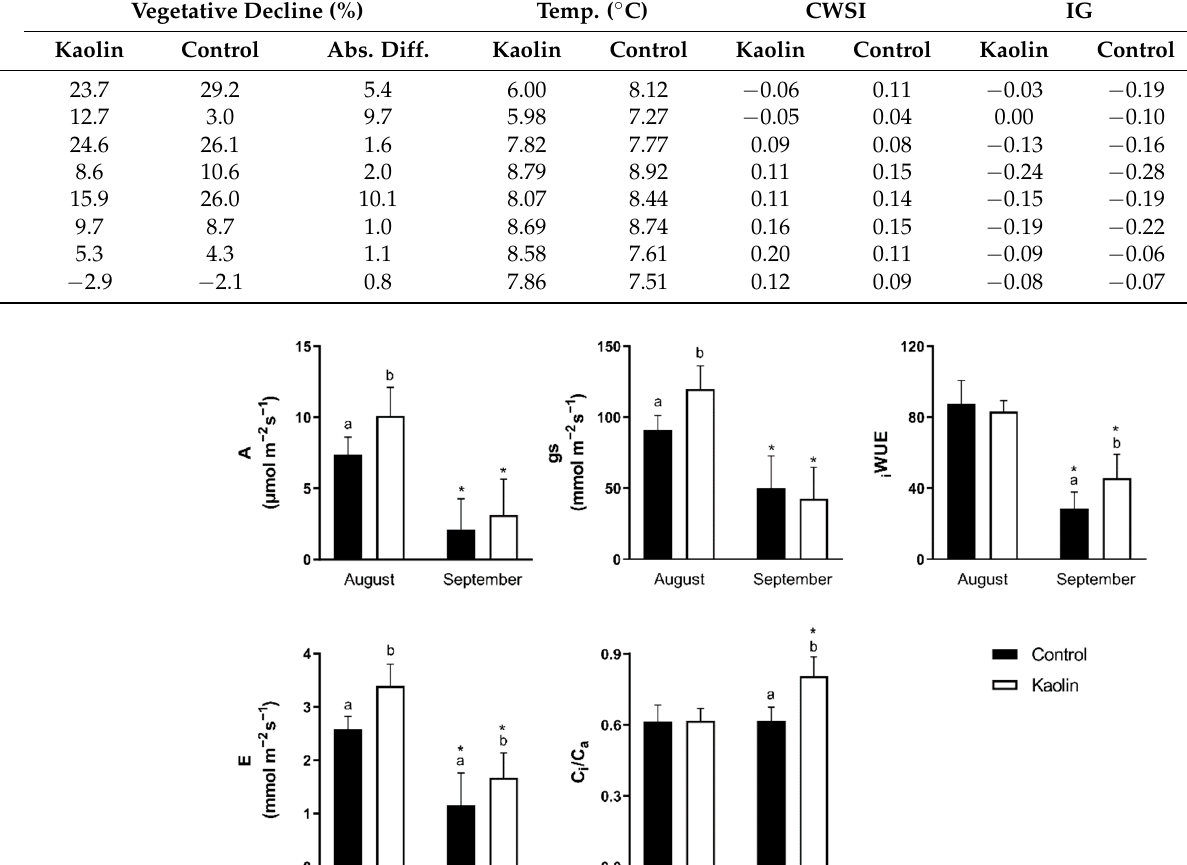
Figure 6. Leaf gas exchange parameters of Touriga Nacional control and kaolin ‐ treated grapevines at midday (14:00 GTM+1). Stomatal conductance (g s , mmol m − 2 s − 1 ), net CO 2 assimilation rate (A, µ mol m − 2 s − 1 ), intrinsic water use efficiency (A/g s , μ mol mol − 1 ), intercellular CO 2 concentration (C i ), ratio of intercellular to atmospheric CO 2 concentration (C i /C a ), and transpiration rate (E, mmol m − 2 s − 1 ). Data are mean ± SD of six replicates. Different lower ‐ case letters represent significant differences between treatments (control vs. kaolin ‐ treated) within each month. * p < 0.05 represent significant differences between sampling months (August vs. September) within each treatment.